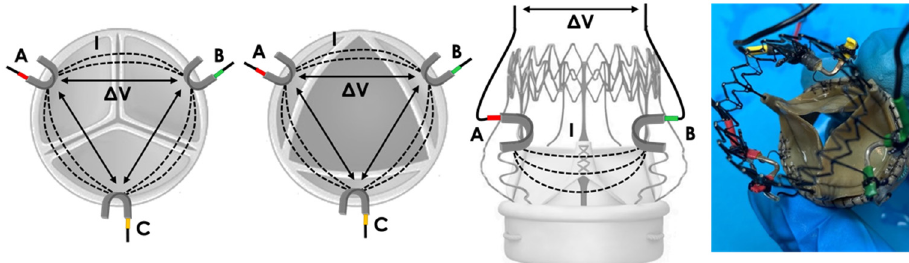
Figure 7. Prototype 3: positioning of “arch” electrodes A (red), B (green) and C (yellow). Local electric field lines (I) and the corresponding potential difference measurement ( ∆ V) are represented for each pair of electrodes.